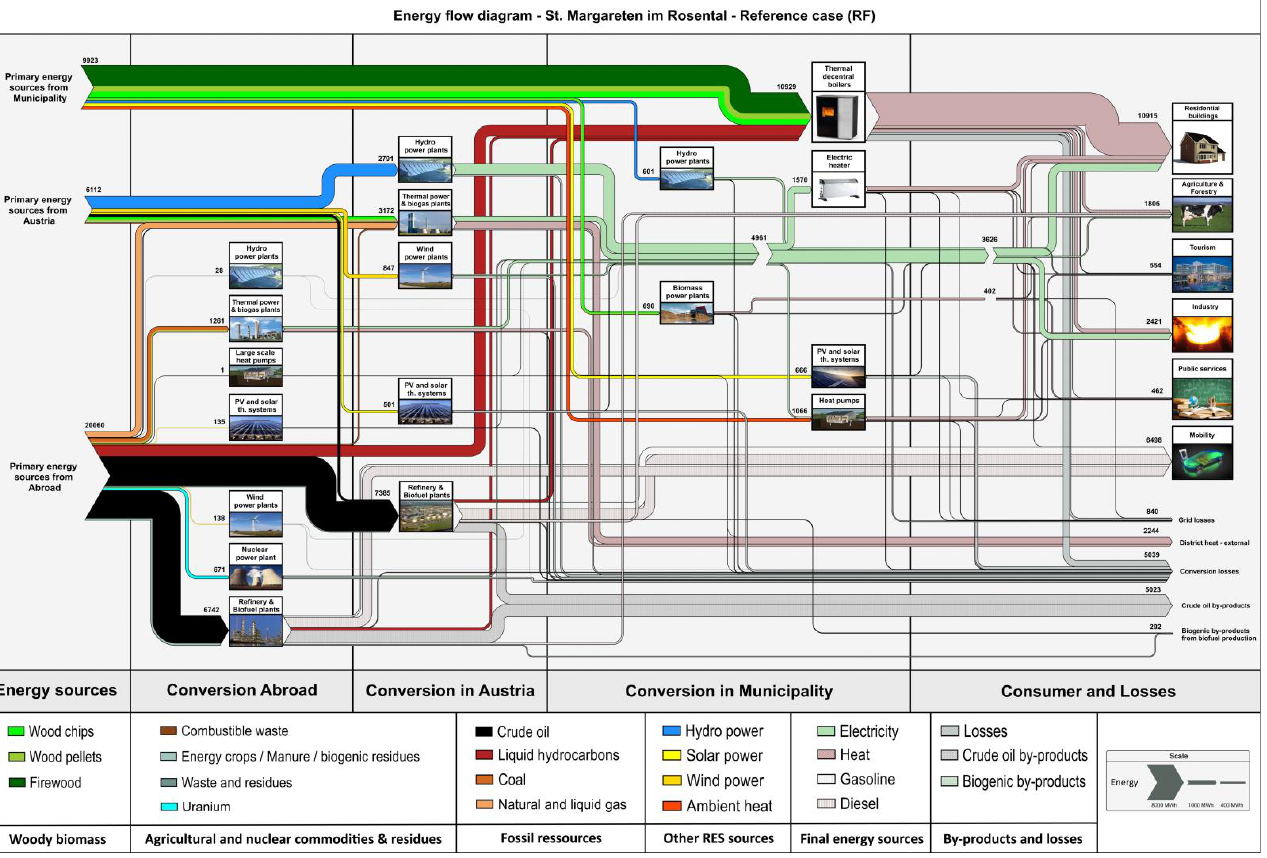
Figure 5. Energy flow diagram of present annual energy demand of St. Margareten im Rosental from reference case (2020 RF).